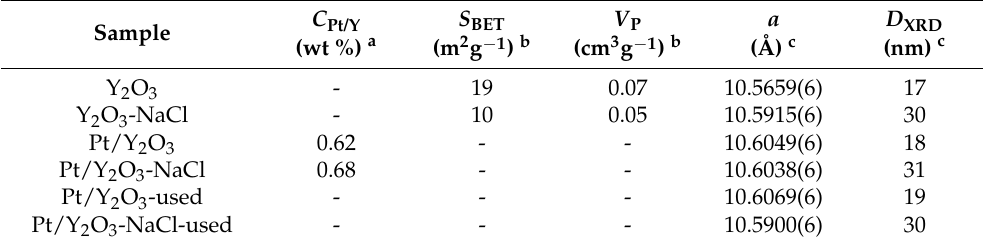
Table 1. Metal mass ratios of Pt/Y 2 O 3 ( C Pt / Y ), BET specific surface areas ( S BET ), BJH pore volume ( V p ), lattice constants ( a ) of Y 2 O 3 and average particle sizes calculated from XRD ( D XRD ).